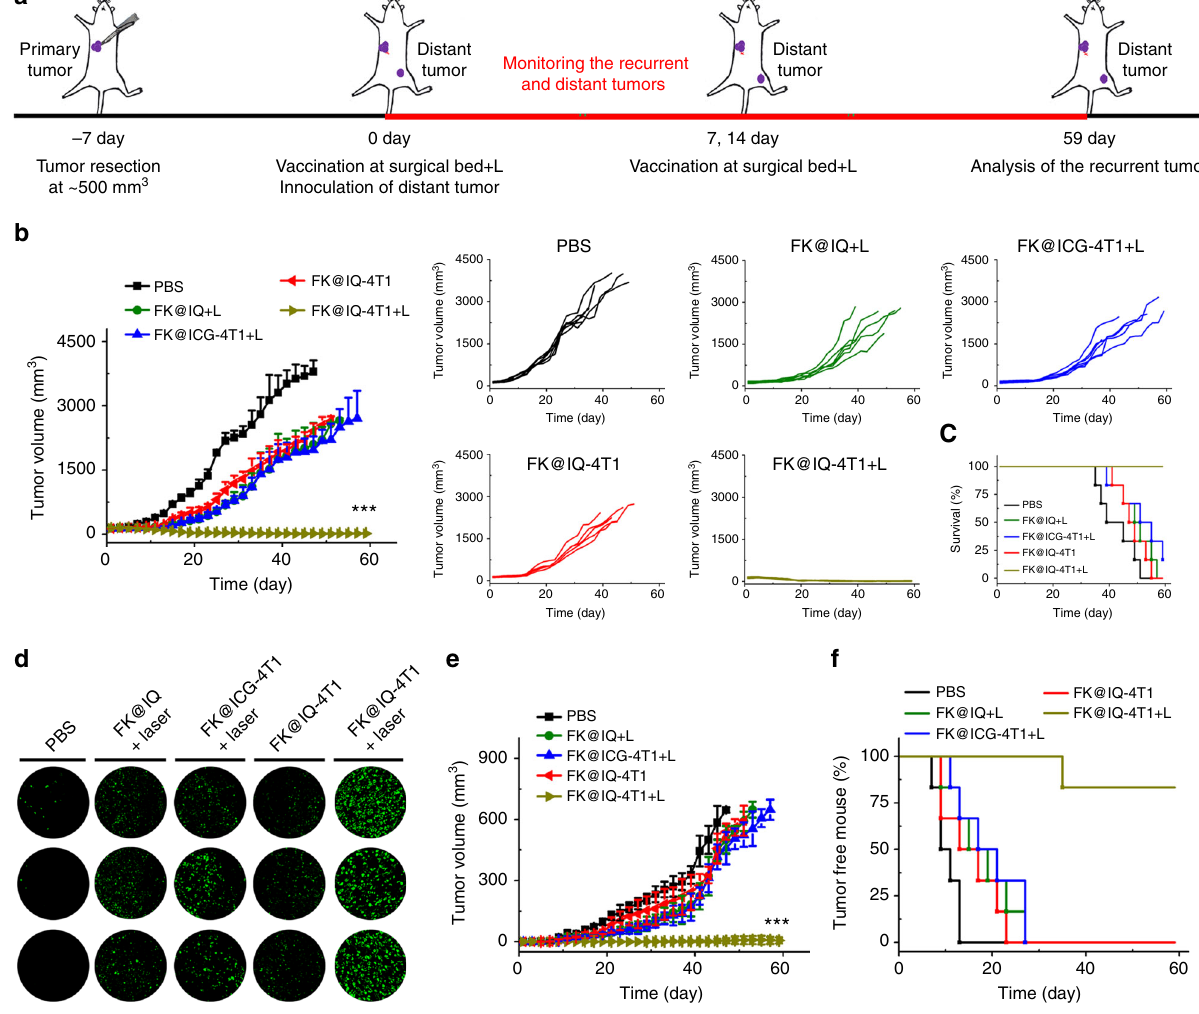
Fig. 4 PVAX-performed immunotherapy in recurrent and metastatic 4T1 xenografts. a Treatment schedule for the immunotherapy. b Average and individual tumor growth curves of the recurrent tumors receiving different treatments (laser irradiation for 2 min at photodensity of 2.0 W/cm 2 ). The mean tumor volumes were analysed using one-way ANOVA. *** p < 0.01. Data represent mean ± s.d. ( n = 6). c Survival percentage of the 4T1 recurrent tumor- bearing BALB/c mice receiving different treatments. d TUNEL staining of the tumor sections examined at the end of antitumor study. e Growth inhibition of the distant tumors via PVAX + L. The mean tumor volumes were analysed using one-way ANOVA. *** p < 0.01. Data represent mean ± s.d. ( n = 6). f Tumor- free percentages of the BALB/c mice rechallenged with the distant